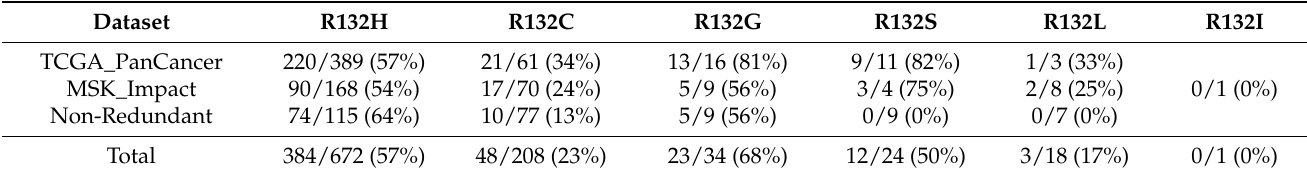
Table 4. Co-occurrence frequencies of specific IDH1 -R132 mutation and TP53 alteration in human